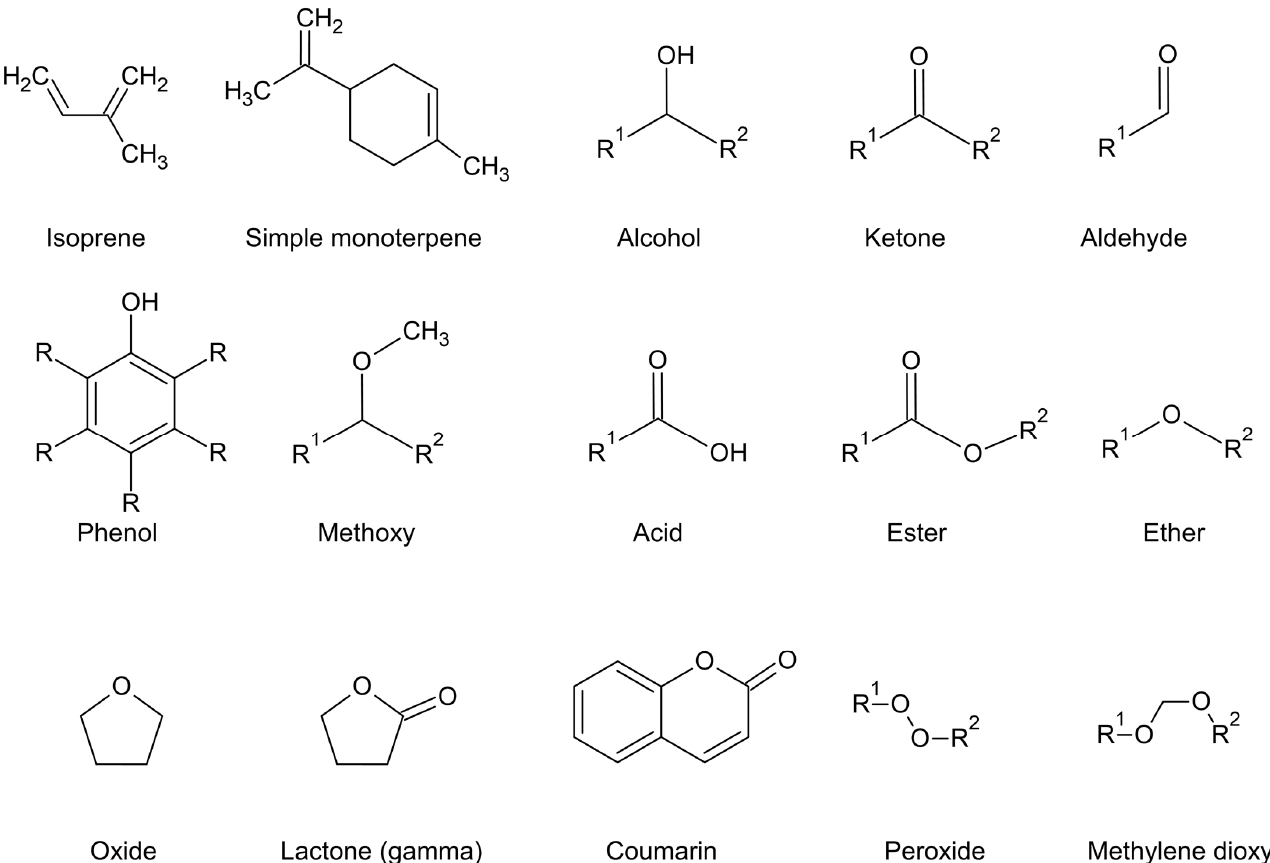
Figure 5. Character of oxidation and corresponding chemical class.